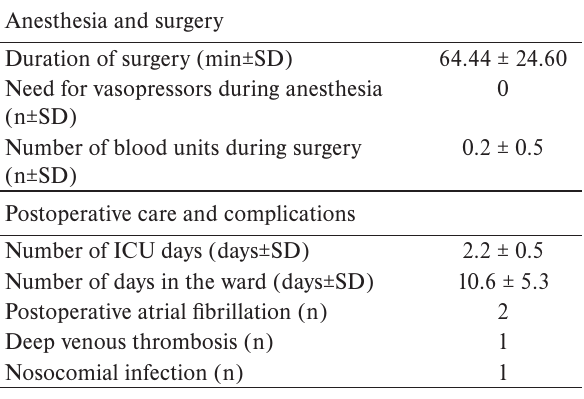
Table 3. Characteristics of anesthesia, surgery, and postoperative care.